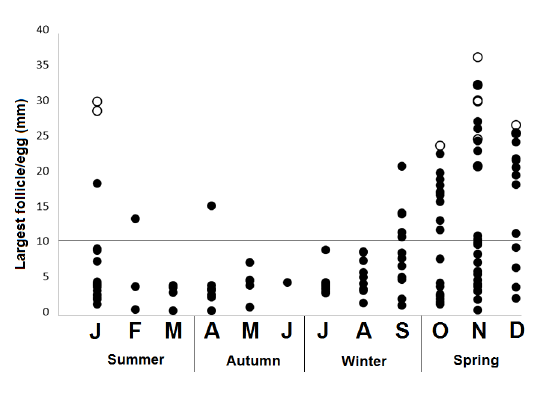
Figure 2 - Monthly variation in the diameter (mm) of the largest follicles (black circles) and eggs (white circles) of Erythrolamprus poecilogyrus sublineatus from the southern Brazilian coast. The horizontal line indicates the size from which follicles were considered as being in secondary vitellogenesis (secondary